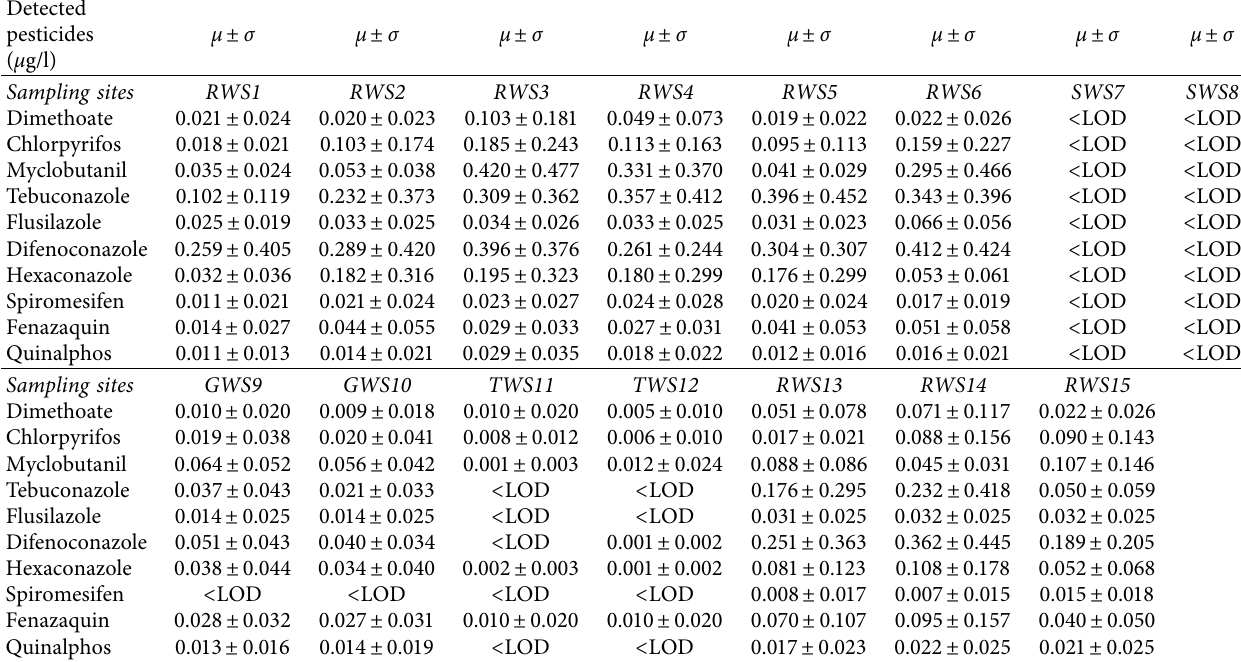
Table 4: Distribution of detected pesticides residues in diferent water sources of south Kashmir. Detected